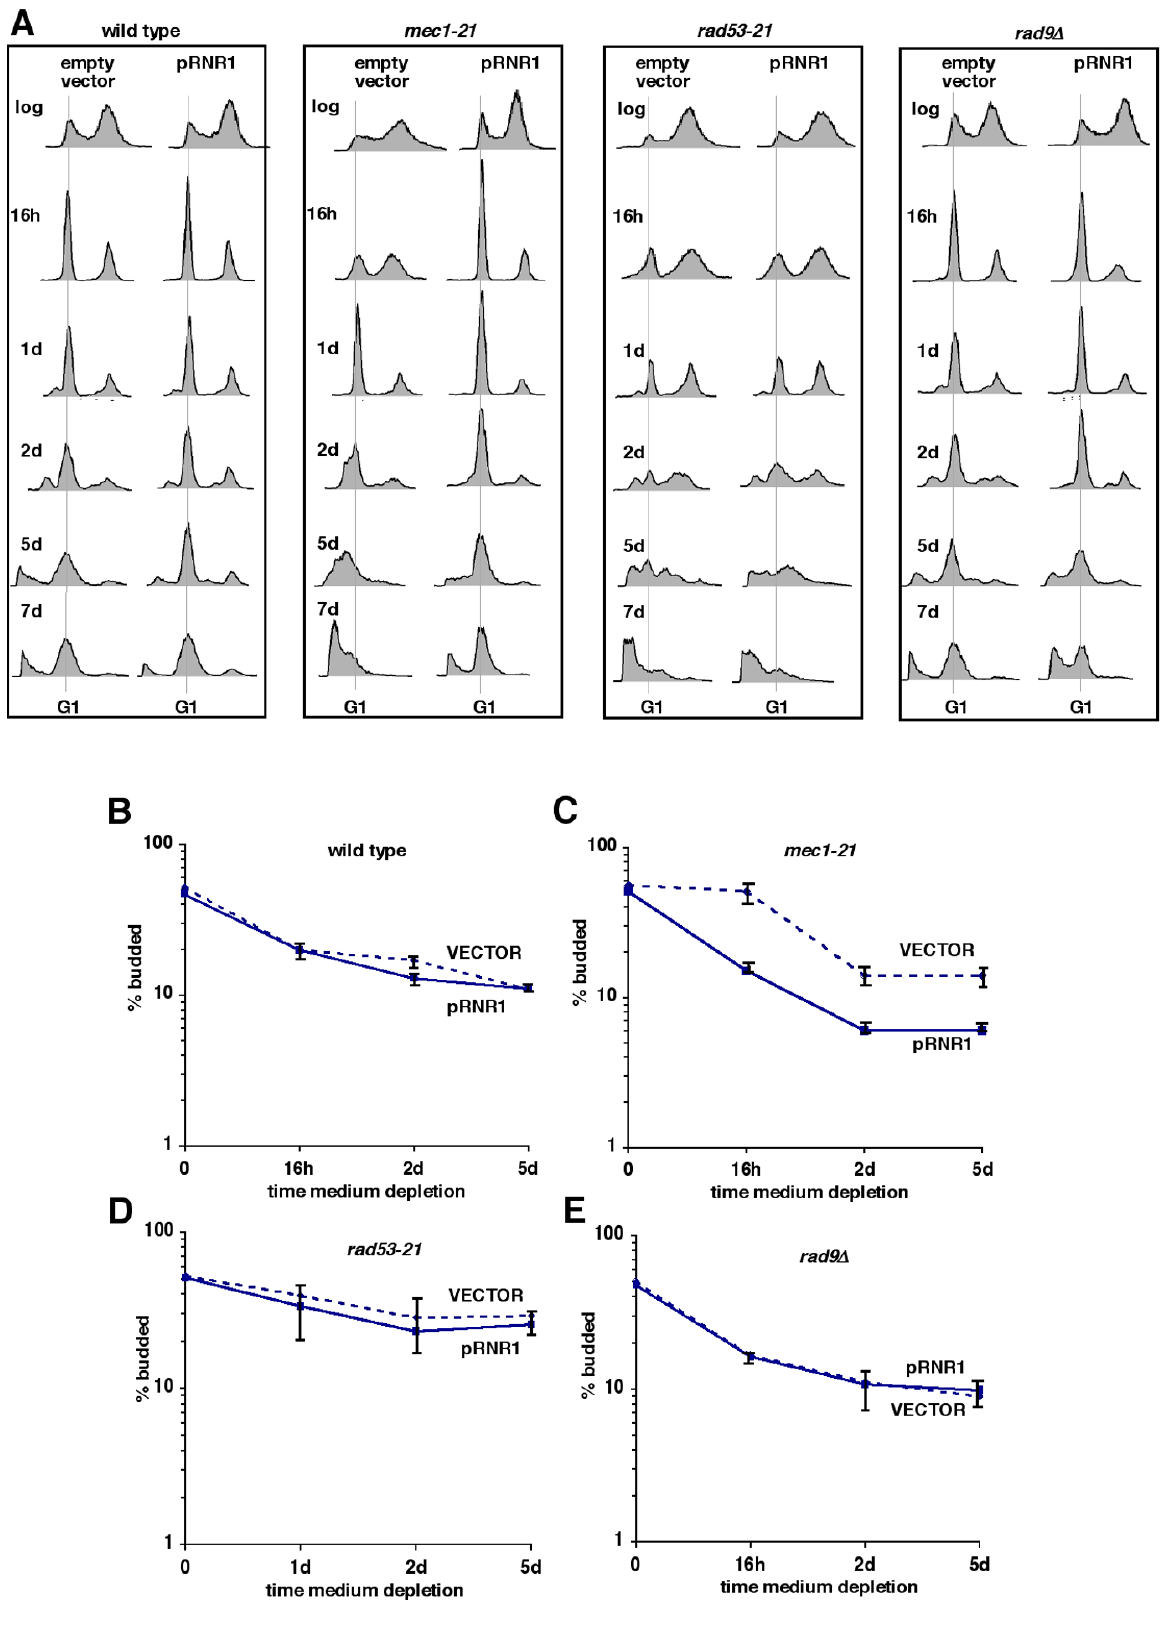
Figure 4. Ectopic expression ofRNR1suppresses increased apoptotic DNA degradation and less efficient G1 arrest inmec1-21, but notrad53-21 cells during nutrient depletion. A. DNA content of wild-type (W303) and indicated checkpoint mutant strains transformed with an empty vector or a high copy plasmid expressing RNR1 (‘‘pRNR1’’) during nutrient depletion in SC medium. B–E . Budding index of these strains during nutrient depletion in SC medium. Error bars depict the standard error for measurements made in three or more independent experiments. doi:10.1371/journal.pone.0000748.g004 PLoS ONE |